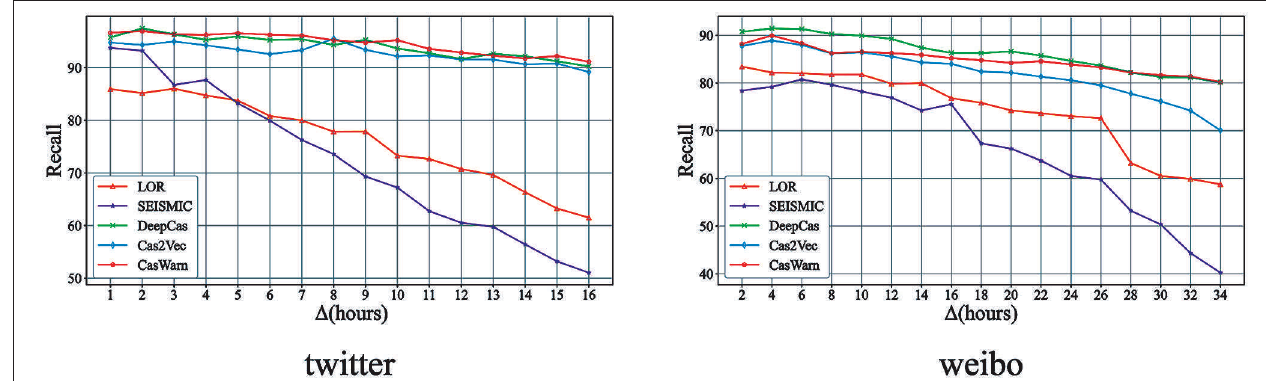
FIGURE 2 | Evaluation results of early prediction experiments for the Twitter and Weibo datasets.